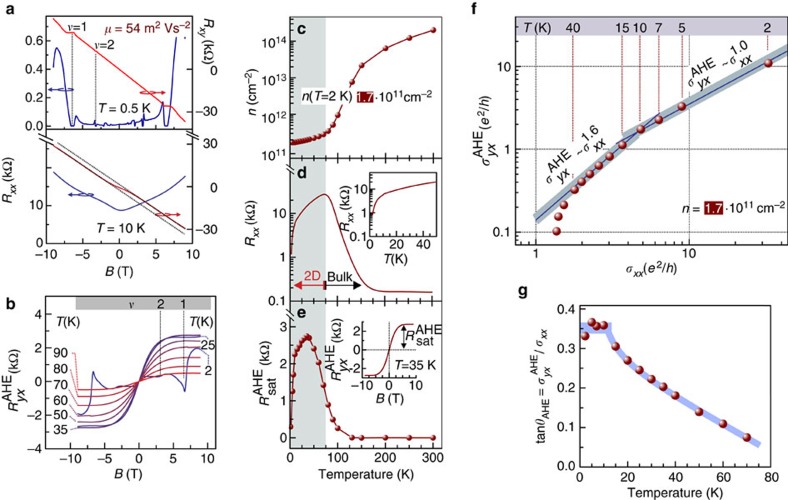
Sample characteristics establish the anomalous Hall effect.(a) Magnetotransport Rxx and Ryx at two representative temperatures. (b) Anomalous Hall effect component at different temperatures. The Landau level integer filling factors ν becomes visible at T<8 K. (c) Temperature dependence of the charge carrier density extracted from the ordinary Hall effect in high field. (d) Four-point resistance Rxx as a function of temperature. (e) Temperature dependence of the saturated value of anomalous Hall effect resistance . (f) AHE scaling: ∝. α=0.94±0.08 is observed between 2 and 10 K, whereas α>1 at higher temperature. (g) AHE angle increases with the decreasing temperature.